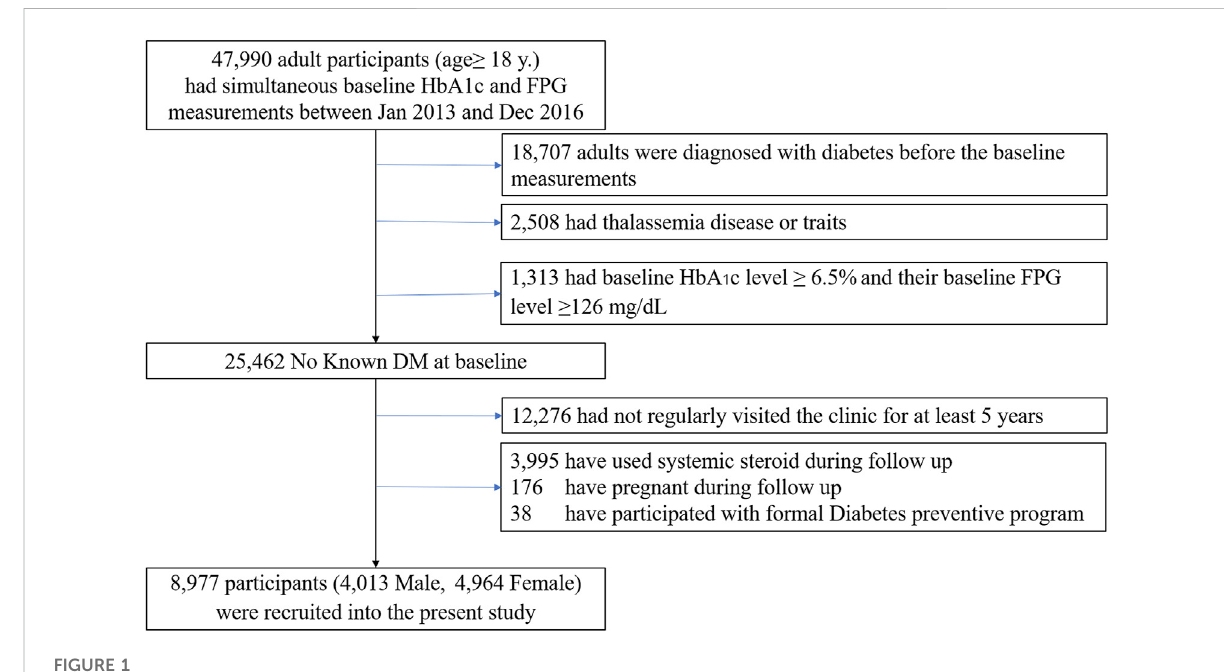
FIGURE 1 Enrollment of the study